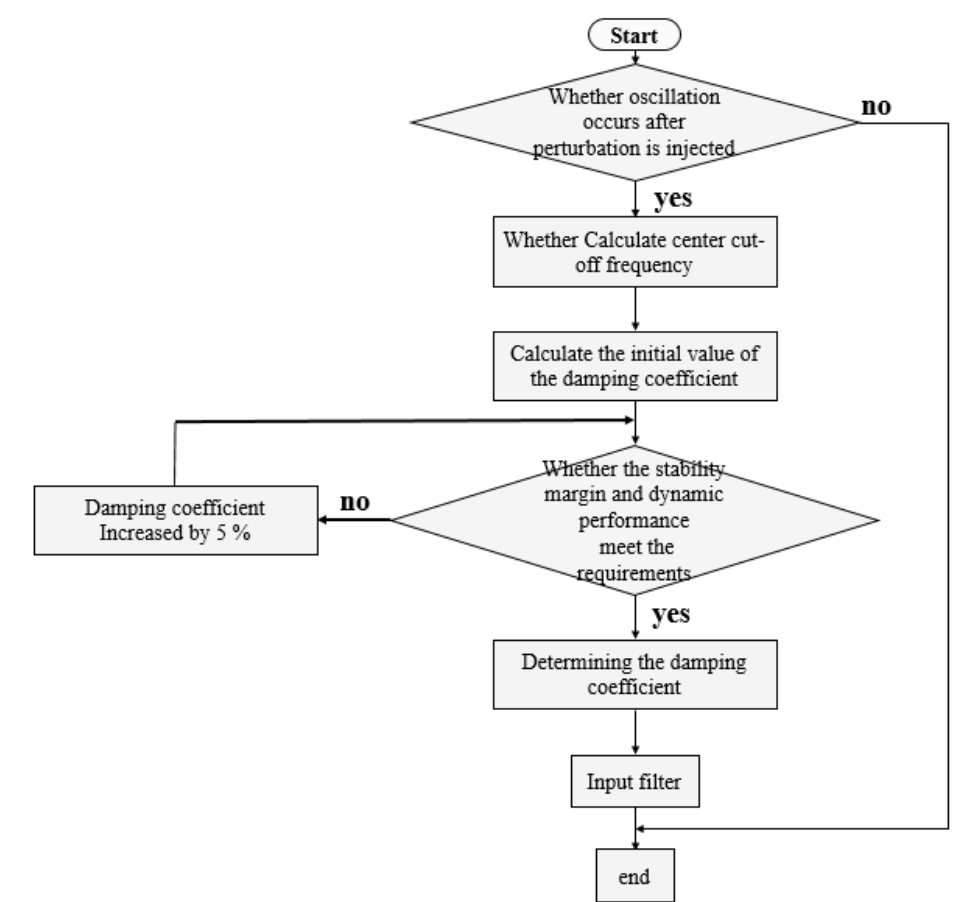
Figure 15. Resonance suppression process based on additional nonlinear low-pass filter.